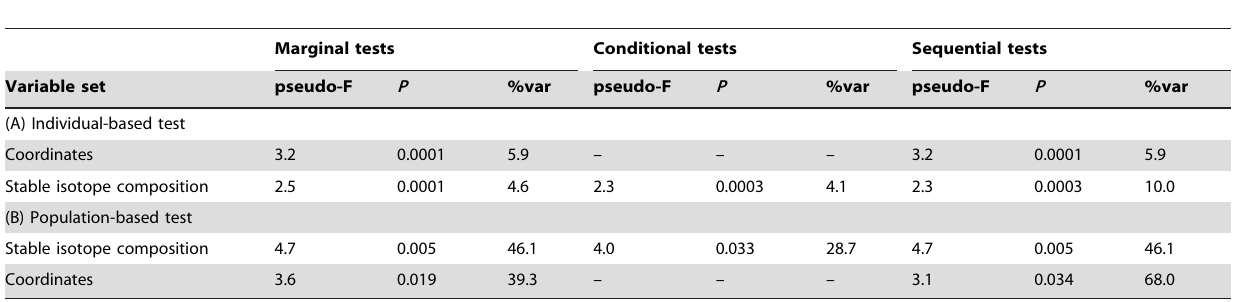
Table 4. Effects of dietary differentiation and geographic distance on genetic differentiation of Eastern European